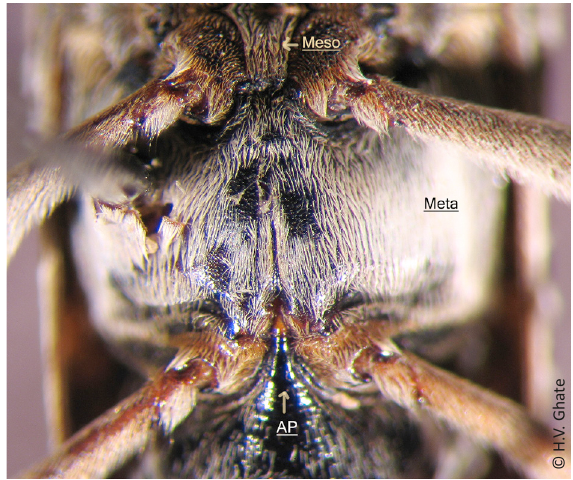
Image 7. Pubescent prosternal process of Apiocephalus .